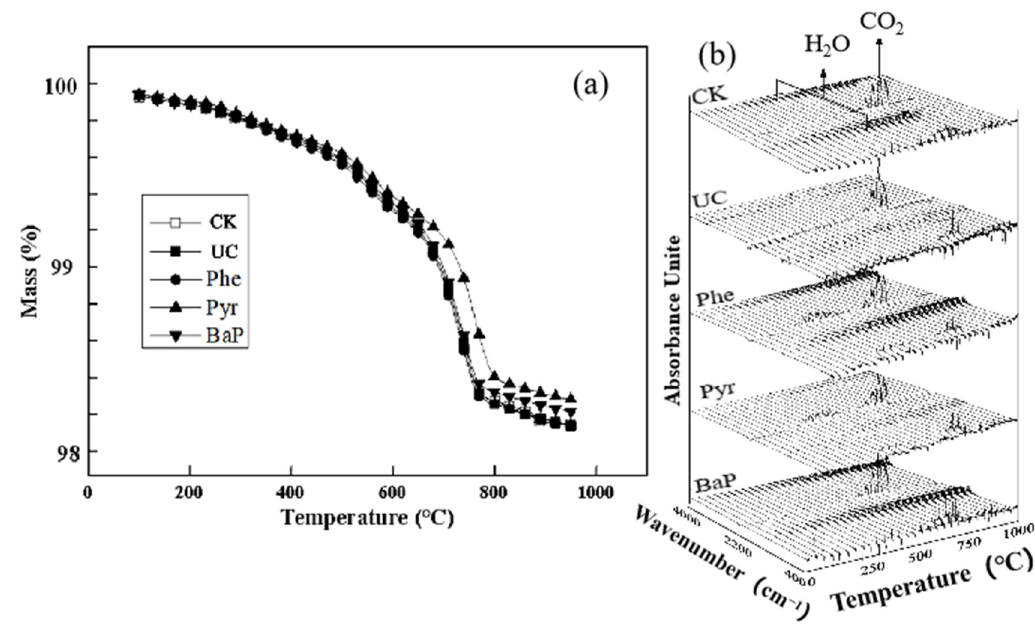
Figure 3. Thermogravimetric curve ( a ) and TG-FTIR ( b ) spectra of contaminated soil. Table 5. Kinetic parameters for the PAH-contaminated soil.